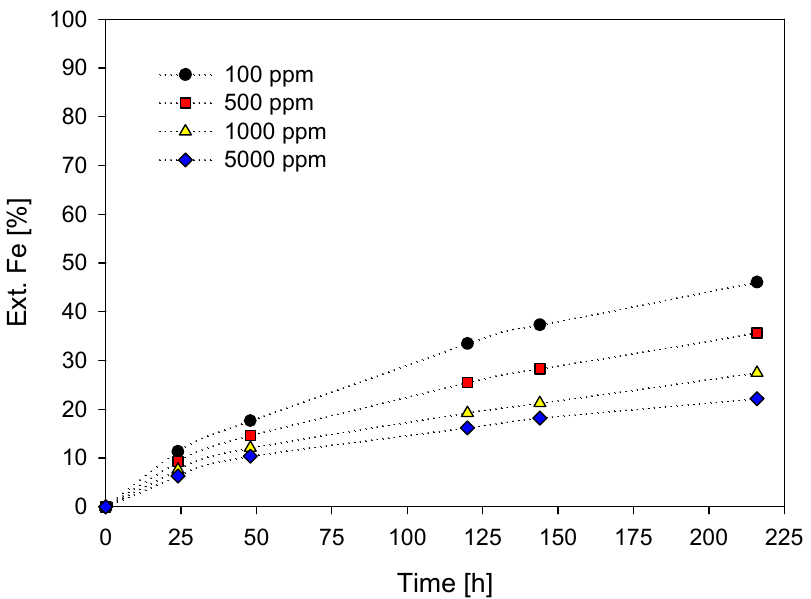
Figure 7. % Fe Ext. vs leaching time. [KI] = ( ) = 100 ppm; ( ■ ) = 500 ppm; ( ▲ ) = 1000 ppm; ( ) = 5000 ppm. [Conditions: H 2 SO 4 = 0.5 M, T= 45 °C, 50 g of sample in 1000 mL of solution of seawater, 450 rpm].